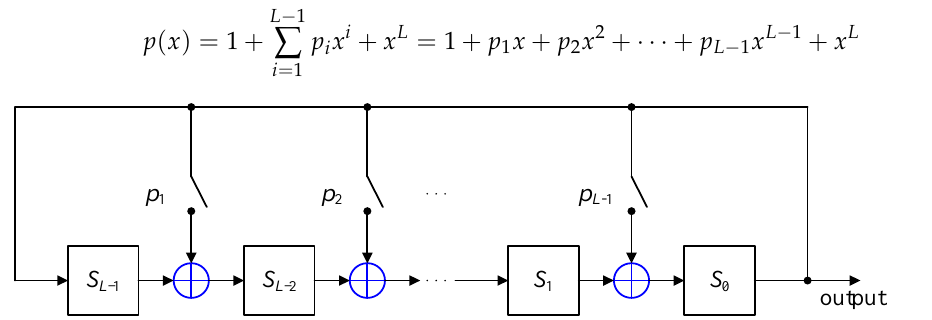
Figure 2. The Galois structure of a LFSR.